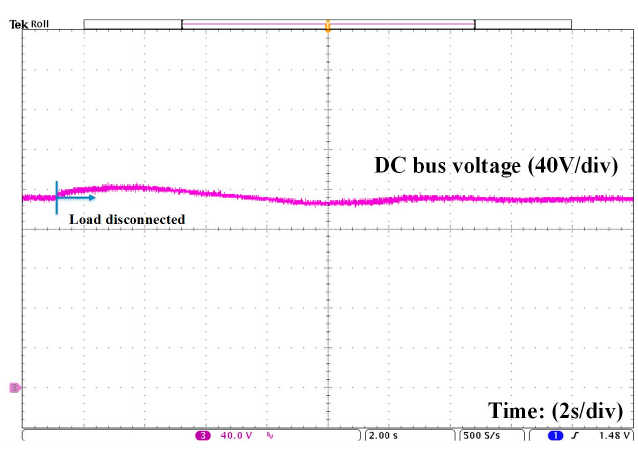
Figure 30. Disconnection of 400 W fluorescent lamps. Table 8. Response of the DC- µ G to the connection and disconnection of loads and